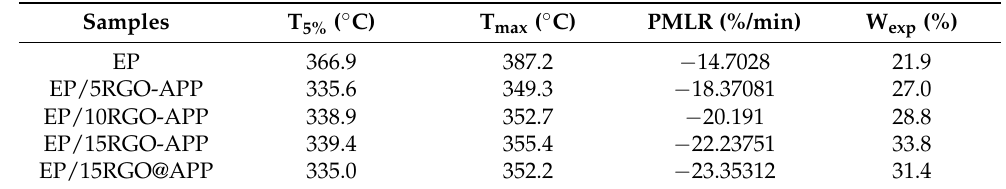
Table 2. Thermogravimetric analysis and derivative thermogravimetric analysis data of pure EP and flame-retardant EP.